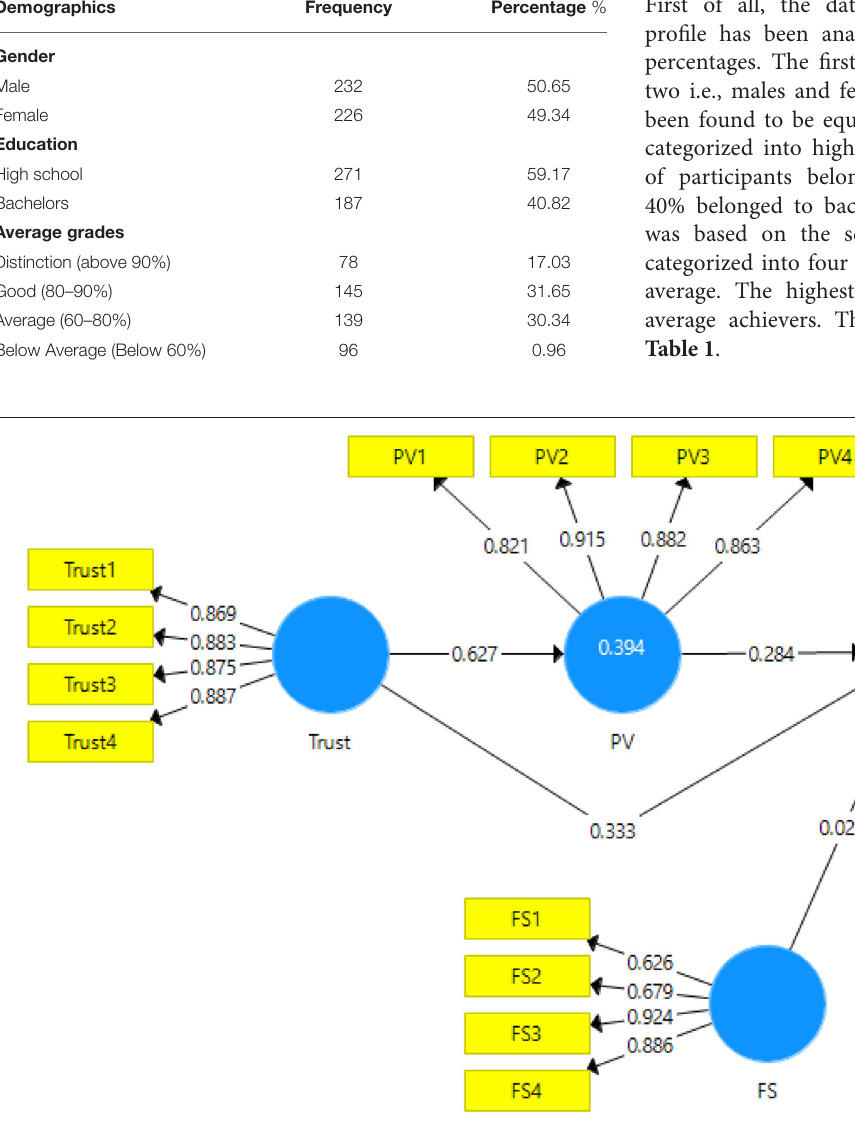
FIGURE 2 | Output of measurement model. Trust, trust in wellbeing information; PV, Preventive behavior; MWB, Mental wellbeing; FS, Family Support; FS*PV, Moderating effect of family support.